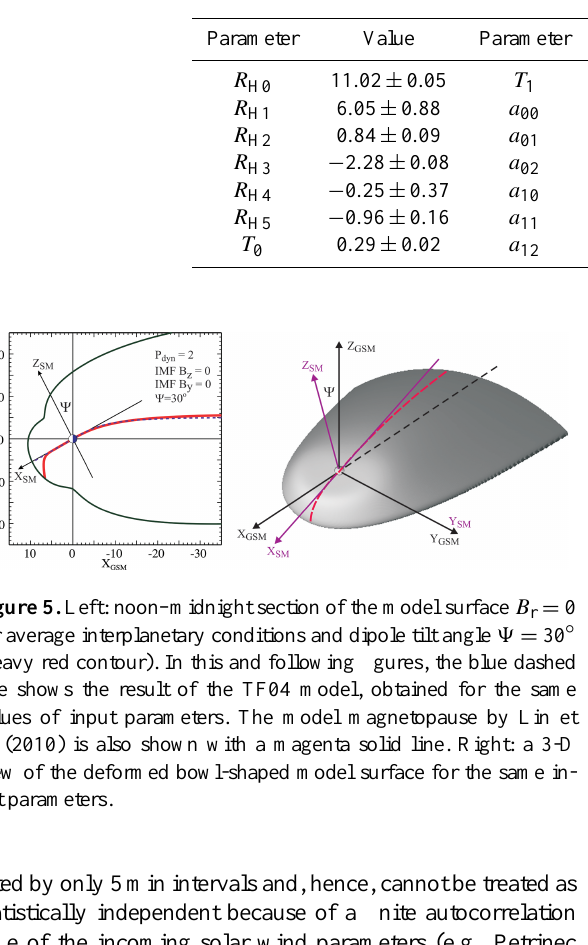
Table 1. The model parameter values.